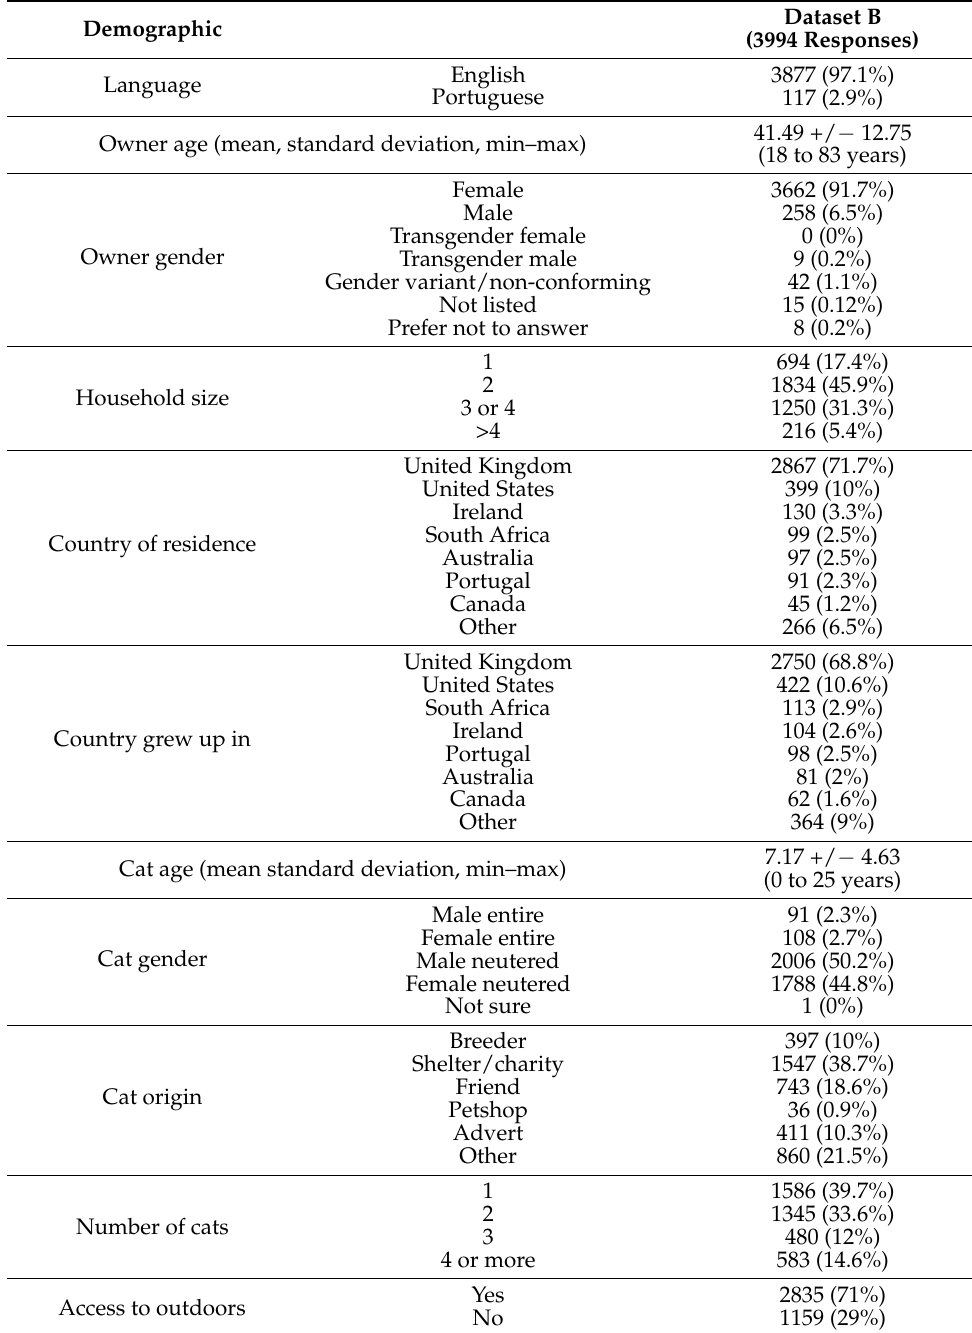
Table 1. Dataset B—population distribution by demographic category, after removing from the dataset all the responses that had at least one blank answer to the 26 items considered reliable. All variables were within 1% of dataset A, except: household size—2 (1.1%), cat gender—male